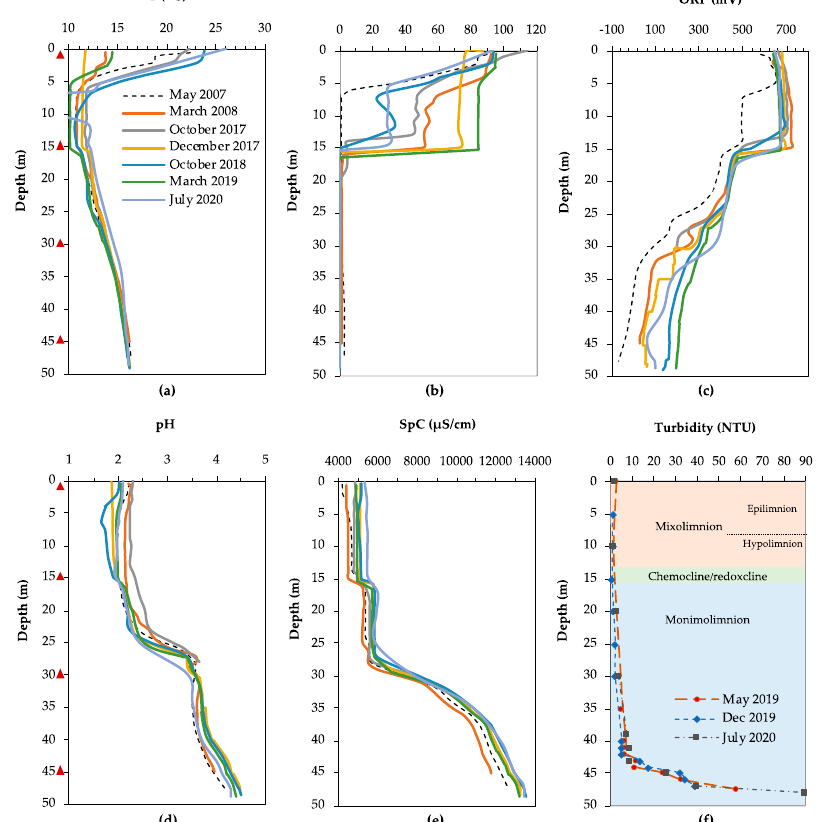
Figure 2. Physicochemical profiles of the water column in Fil ó n Centro (FC). ( a ) Temperature (T), ( b ) dissolved oxygen (DO), ( c ) oxidation–reduction potential (ORP), ( d ) acidity (pH), ( e ) specific conductivity (SpC), and ( f ) turbidity (in nephelometric turbidity units (NTU)) profile combined with the chemical zonation of the water column inferred from the combined physicochemical profiles. Triangles indicate the sampling depths for biomass filtration in October 2017. Data from May 2007 and March 2008 were taken from previous studies for comparison purposes